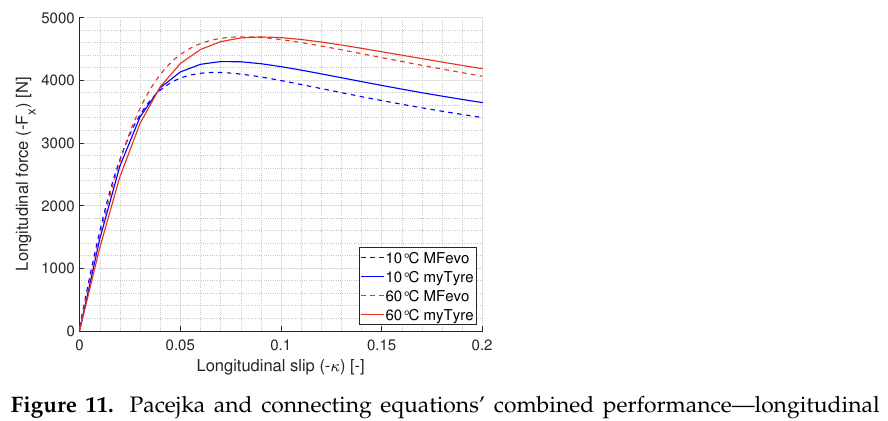
Figure 11. Pacejka and connecting equations’ combined performance—longitudinal force with longitudinal slip ( F z = 3132 N ).